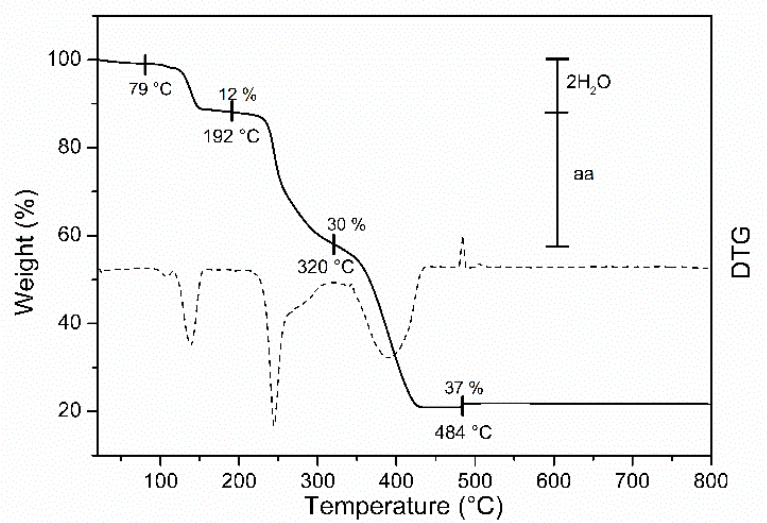
Figure 3. Thermogravimetric (TG/DTG) curves of 3 .